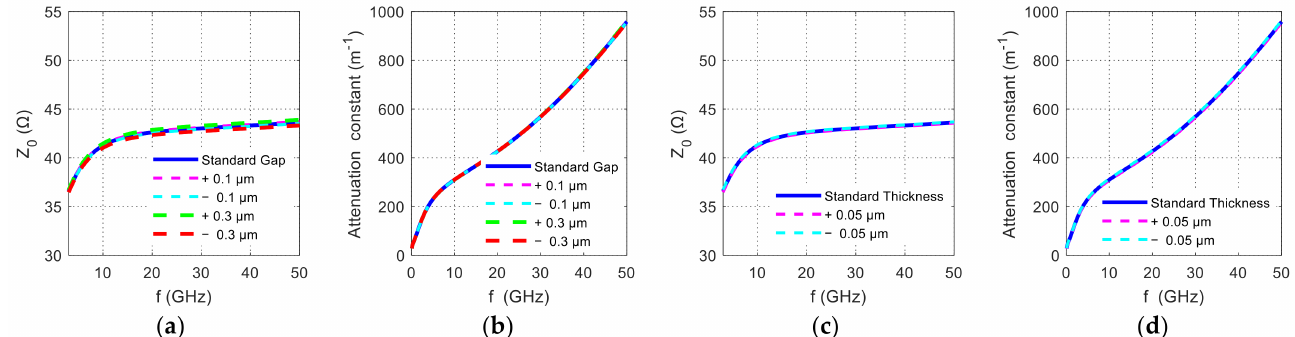
Figure 7. Simulated variation of the TWE with the P-N junction loaded: ( a ) total impedance and ( b ) total power attenuation constant varying with the gap between G and S; ( c ) total impedance and ( d ) total power attenuation constant varying with the electrode